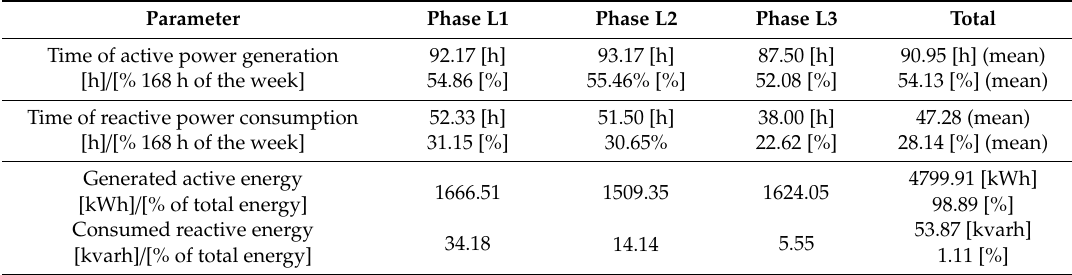
Table 5. Analysis of energy production of the PV power plant during the investigated week in order to determine the impact of reactive power regulation on reducing the availability of the resources integrated into the VPP in the perspective of the observed